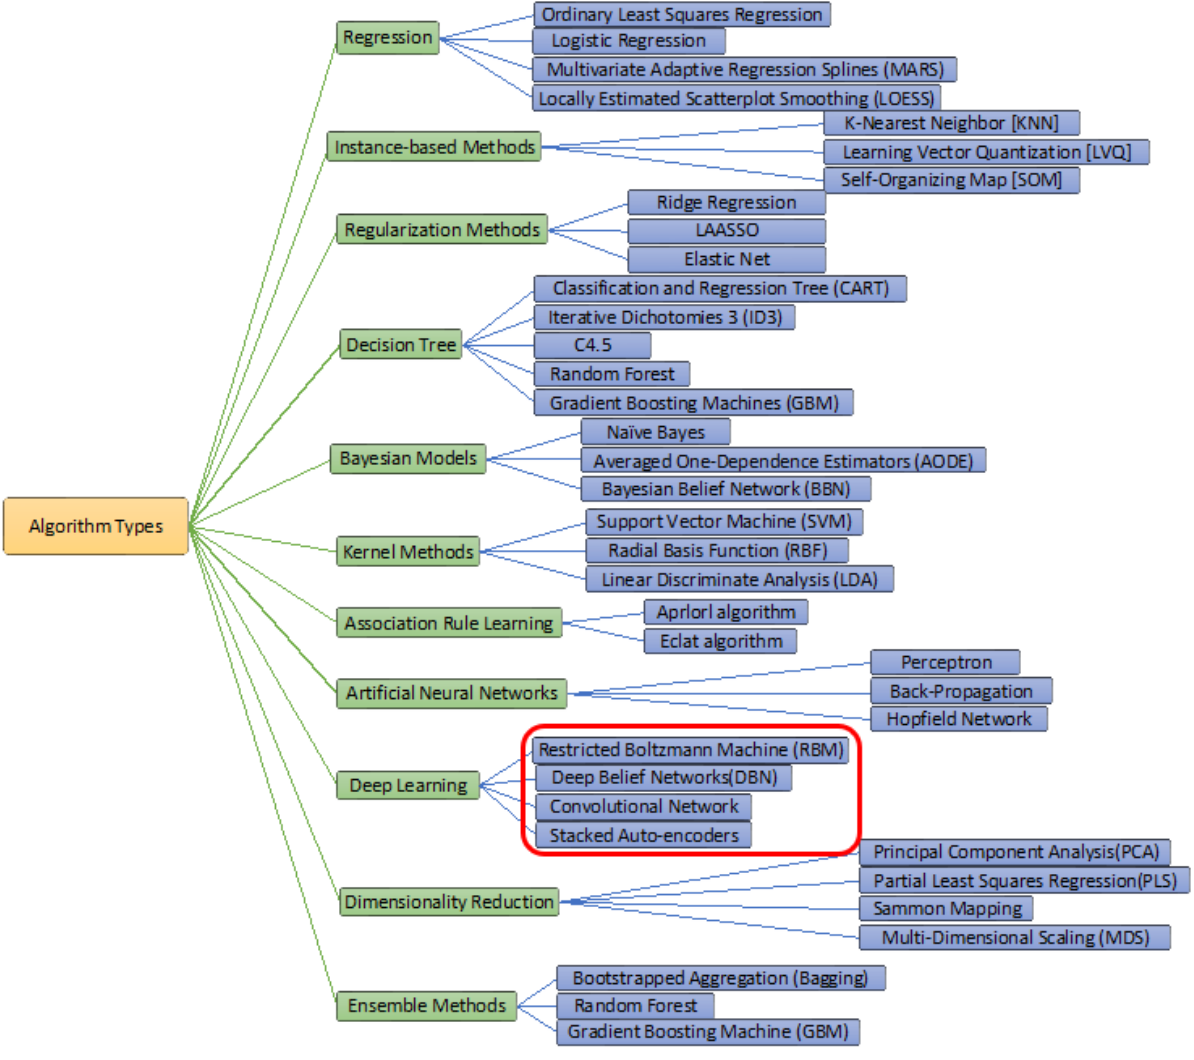
Figure 1. The various types of ML algorithms .